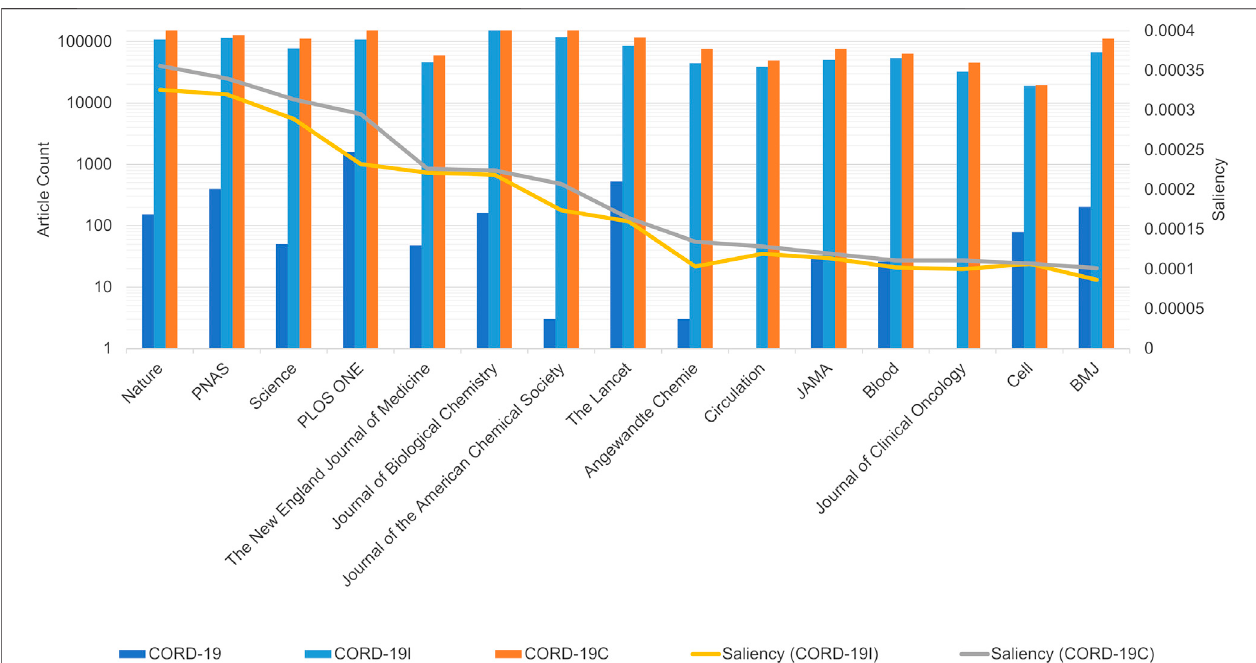
FIGURE 8 | Article counts in COVID-19 Research Dataset (CORD-19) vs. CORD-19C and CORD-19I from top 15 journals ranked by saliencies based on CORD- 19C articles. As in Figure 7 , thedata show uneven coverage ofjournals inCORD-19, especially for highly ranked journals, such asScience, NEJM, and Journal ofACS. The journal saliencies based on CORD-19I are shown as the yellow line along the secondary vertical axis, whose monotonical decrease indicates the journal rankings derived from the partial closure are already in close agreement with those derived from the full closure.